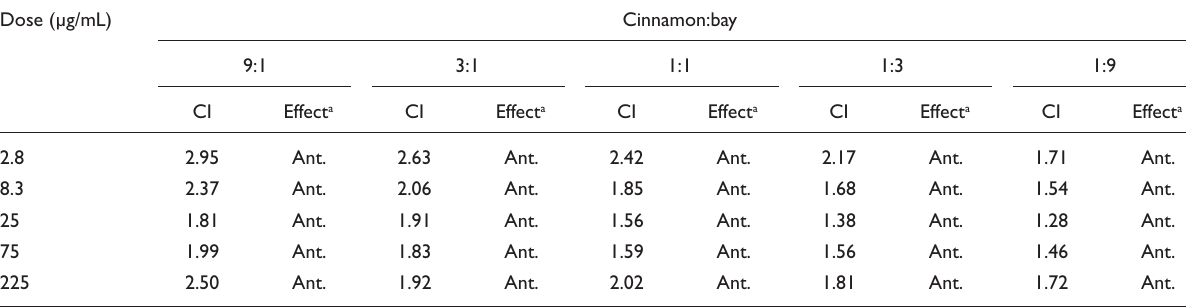
Table 4. The interaction between cinnamon and bay against tyrosinase Dose